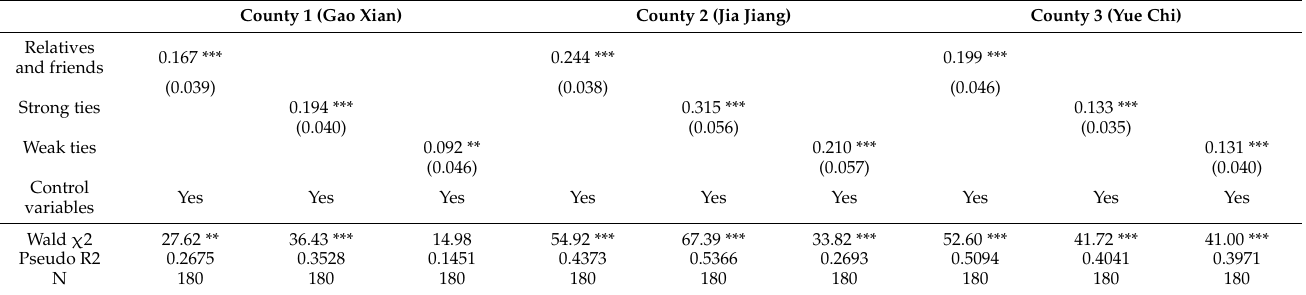
Table 7. Robustness test of farmers’ adaptive behavior to climate